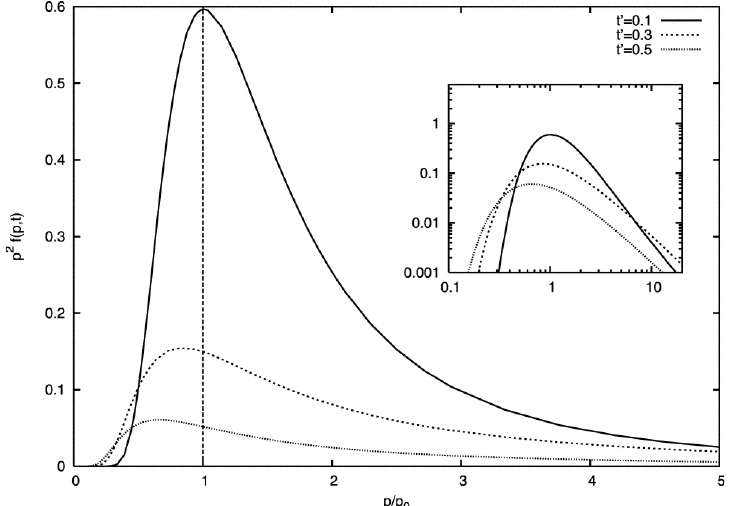
Figure 5. Time-dependent solution f ( p , t ) of the Fokker-Planck diffusion equation for non-relativistic gradual shear acceleration assuming an impulsive, mono-energetic injection with p 0 at t 0 = 0. A linear momentum-dependence τ ∝ p ( α = 1) has been used for the scattering time The distribution broadens with time due to momentum dispersion. The (double logarithmic) inlet illustrates the formation of a power law like distribution n ( p ) ∝ p 2 f ( p ) ∝ p − 2 above p 0 for t (cid:48) ≥ 0.3. From Ref.